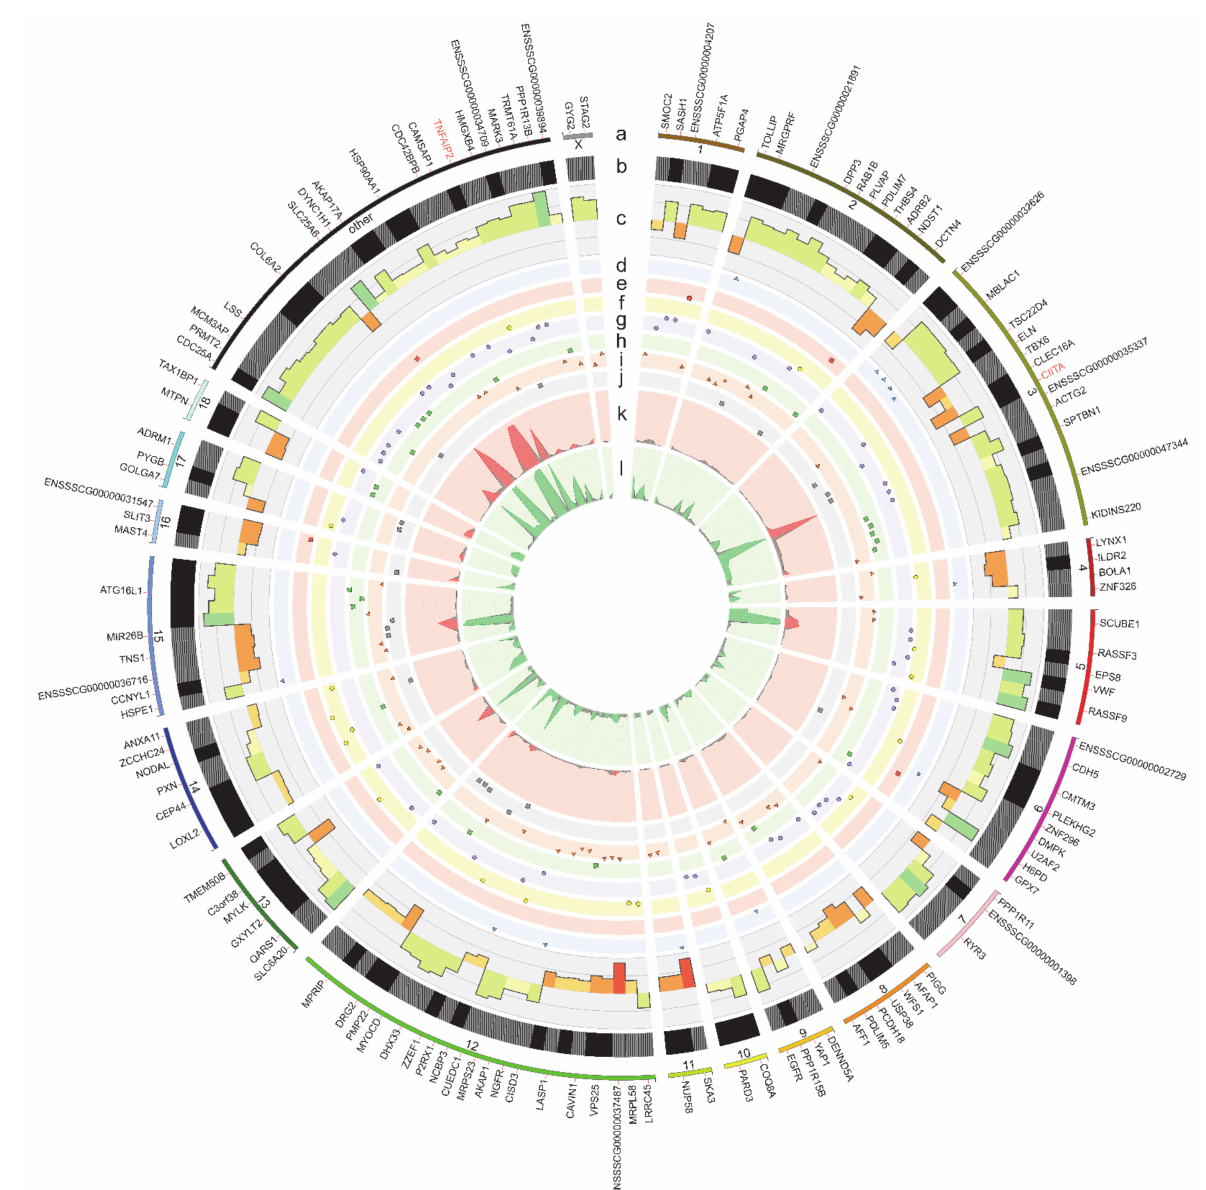
Figure 4. Visualization of the RNA editing candidates exposed to the EMF. ( a ) The external circle represents the porcine chromosomes and other unclassified scaffolds, where the region length is proportional to the number of editing substitutions. Gene names (DEGs are marked in red) identified in the vicinity of RNA candidates are placed outside the track. ( b ) The second track (black and grey lined blocks) presents an abundance of adenine to inosine and cytosine to thymine (A-to-I and C-to-T) types of RNA editing sites. ( c ) The third track, the histogram, depicts the difference in the alternative allele fraction ( ∆ AAF) between the EMF-treated samples and the controls. ( d – j ) The next seven middle scatter plots present the localization of RNA editing substitutions on upstream (blue triangles), 5’UTR (red rectangle), missense (yellow circle), synonymous (purple circle), intron (green squares) 3’ UTR (orange triangle), and downstream region (grey rectangle); vertical axis on each scatter plot shows the normalized FDR. ( k , l ) The two inner tracks show the coverage of the alternative (red histogram) and reference variants (green histogram) in all the RNA-seq libraries. Figure created with Circos